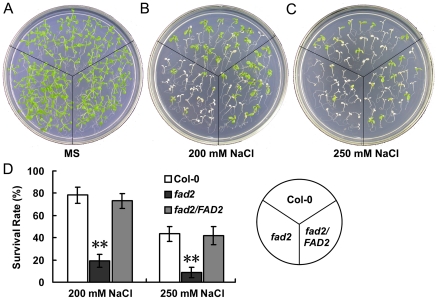
Survival rrates of Col-0, fad2 and fad2/FAD2.(A)-(C), Five-day-old seedlings of Col-0, fad2 and fad2/FAD2 (fad2/FAD2-1) were transferred to MS medium supplemented with 0 (A), 200 (B), or 250 mM NaCl (C). Photos were taken 10 days after the initiation of the stress treatments. (n = 240). (D) Survival rates of plants in (B) and (C). Results are presented as means and standard errors from three independent experiments. ** indicates significant difference in comparison to wild-type at P<0.01 (Student's t-test) (n = 240).